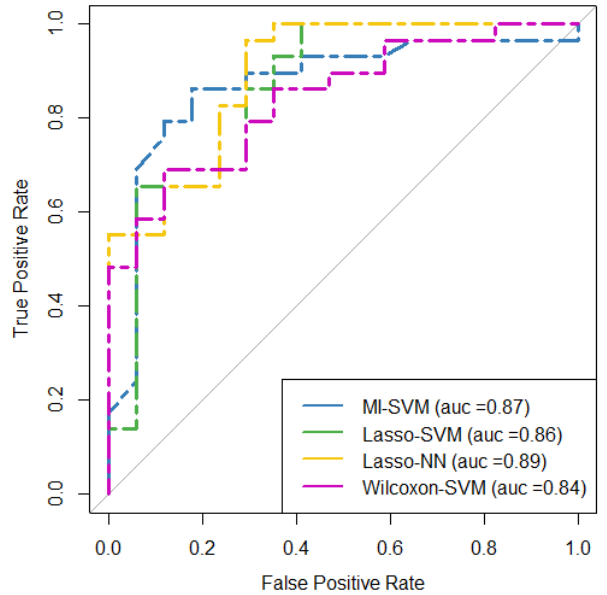
Figure 5. ROC curves for the four predictive models with the highest performance in terms of AUC in the testing cohort. MI = mutual information, SVM = support vector machine, Lasso = absolute shrinkage and selection operator, NN = neural network, AUC = area under the receiver operator characteristic curve, ROC = receiver-operating characteristic.